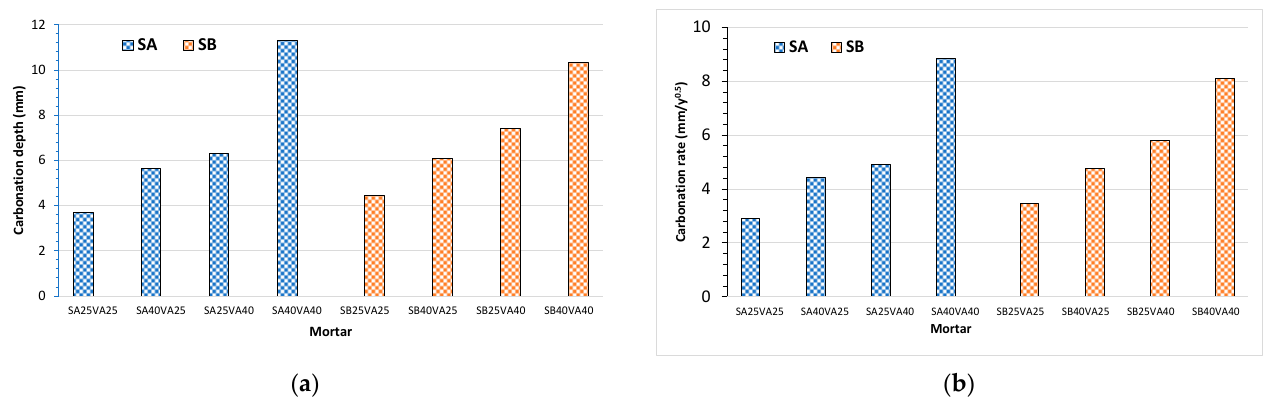
Figure 2. Carbonation resistance of mortar specimens made with ternary cements made with coal fly ash (V) and two ground granulated blast-furnace slags (SA: coarse and SB: fine) at 20 months of natural exposure: ( a ) carbonation depth measurements; ( b ) carbonation coefficients.